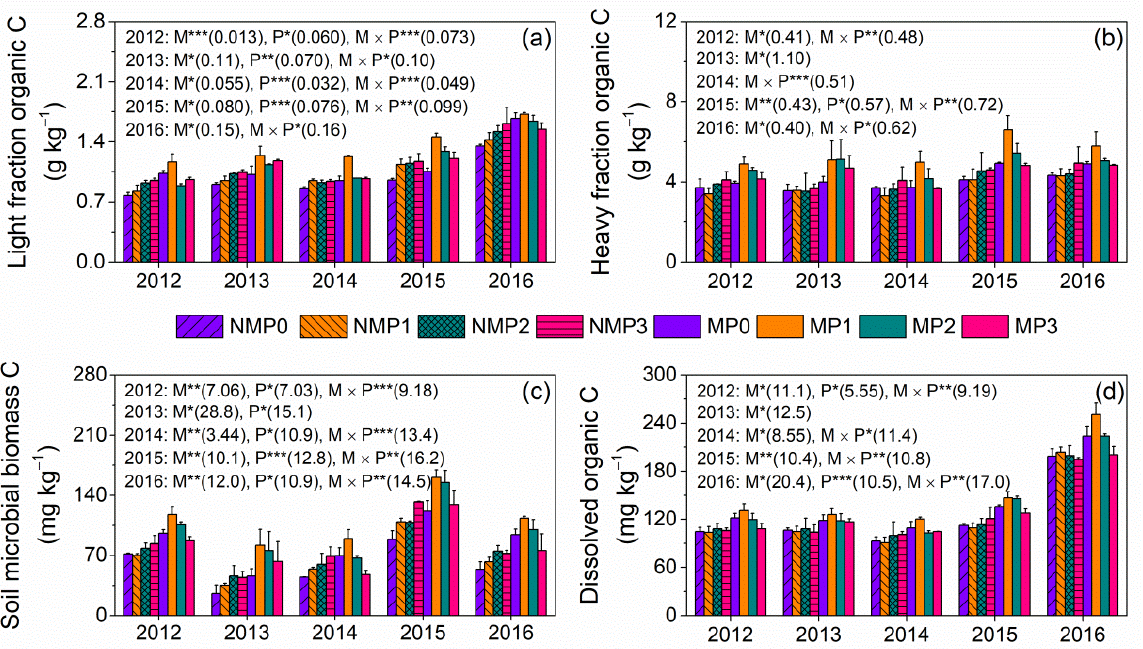
Figure 3. Light fraction (LFOC, a ) and heavy fraction (HFOC, b ) organic C, soil microbial biomass C (MBC, c ), and dissolved organic C (DOC, d ) under no film mulching (NM) and film mulching (M) at four P levels (P0, P1, P2, and P3). * p ≤ 0.05, ** p ≤ 0.01, and *** p ≤ 0.001. Numbers in brackets are LSD at p = 0.05. Error bars are standard deviations.